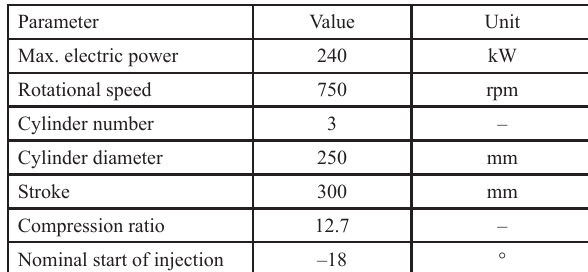
Table 1. Parameters of the test engine [10]